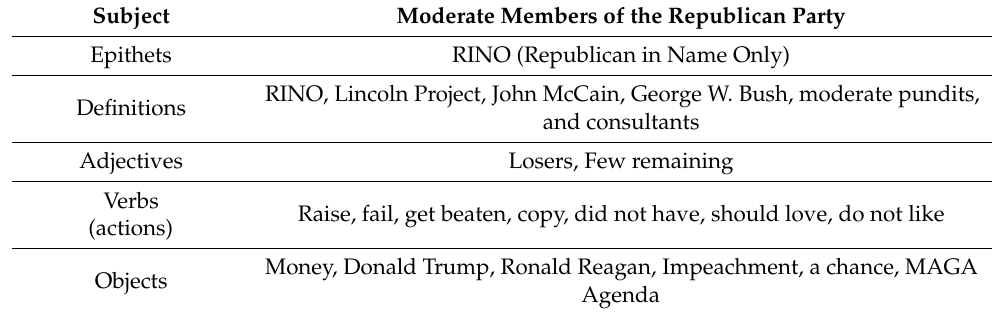
Table 7. Republican “in Name only” (RINO).